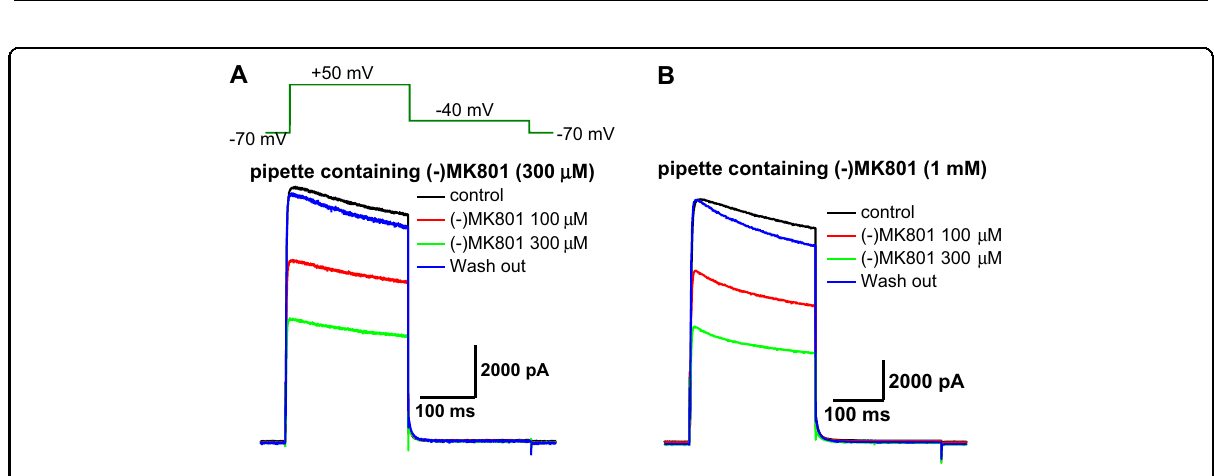
Fig. 2 Inhibition of Kv1.5 currents by MK801 enantiomers recorded from CHO cells overexpressing Kv1.5. a Representative Kv1.5 current tracings elicited by voltage steps shown in the fi gure inset in the absence and presence of MK801 (100 and 300 µM). b Kv 1.5 current amplitudes at + 50 mV are plotted against time. The period of application of various concentrations of MK801 is indicated as solid bars. c CRCs of ( + ) and ( − ) MK801 enantiomer-induced Kv1.5 inhibition. N in parentheses indicates the number of cells examined. N.S. not signi fi cant